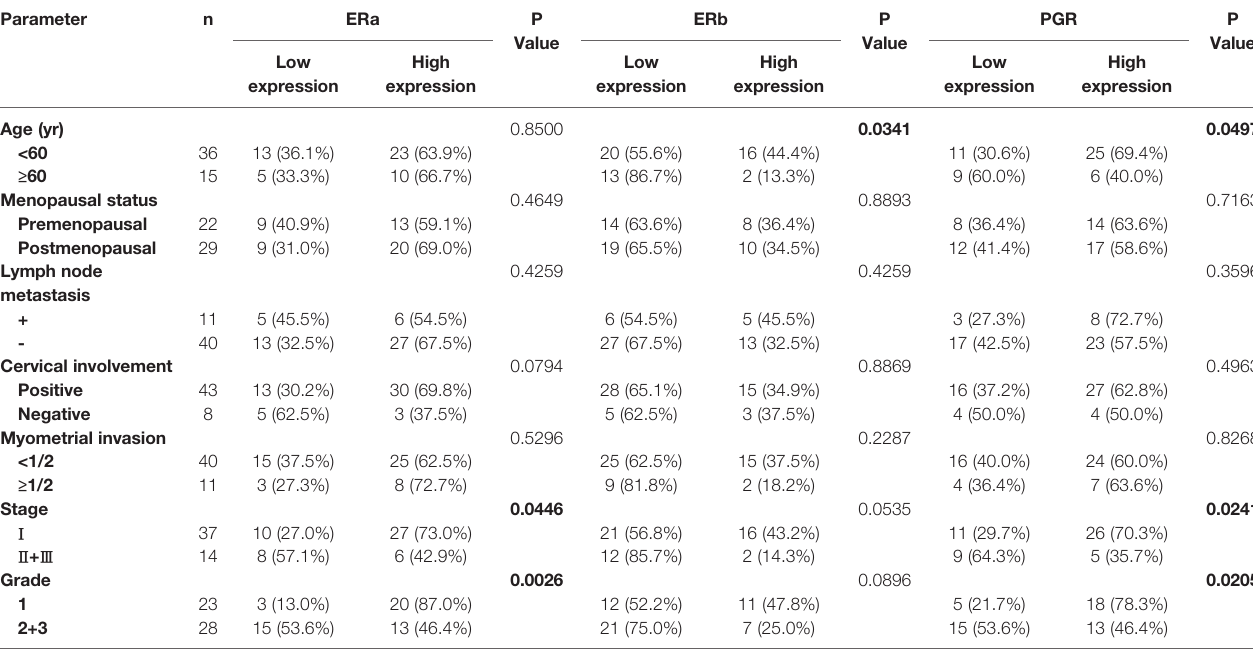
High expression